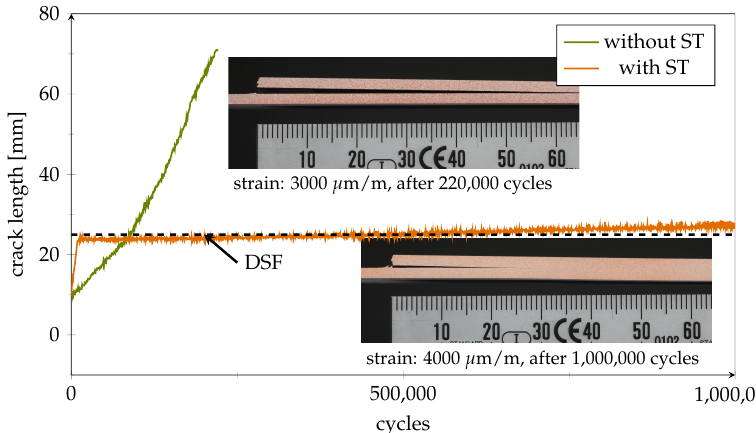
Figure 15. Comparison of optically determined crack progression during fatigue testing. Side views of a reference specimen without inlays (maximum strap strain: 3000µmm − 1 ) and a sensorless specimen equipped with ST inlay (maximum strap strain: 4000µmm − 1 ).